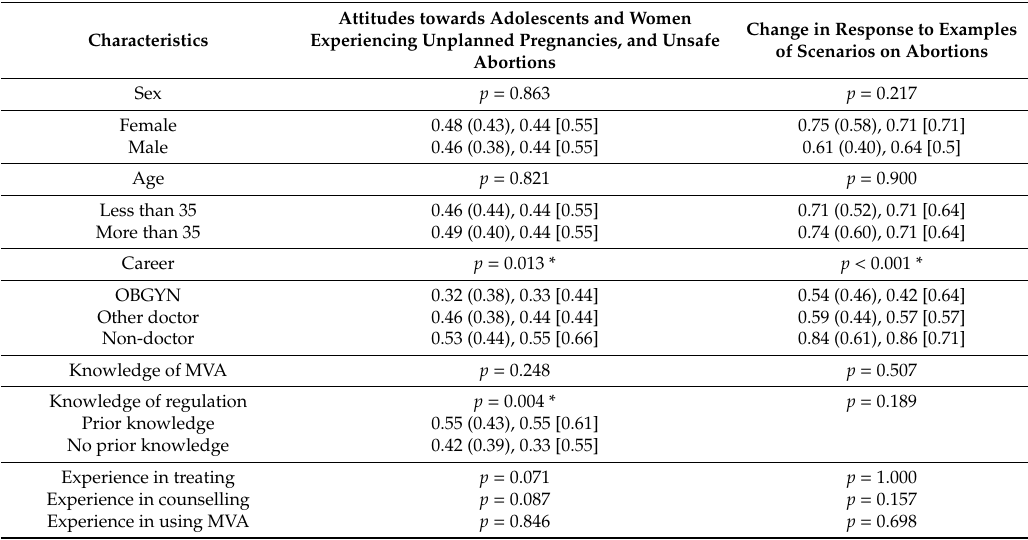
Table 3. Di ff erences in the pre- and the post-test changes in the responses according to demographic and professional